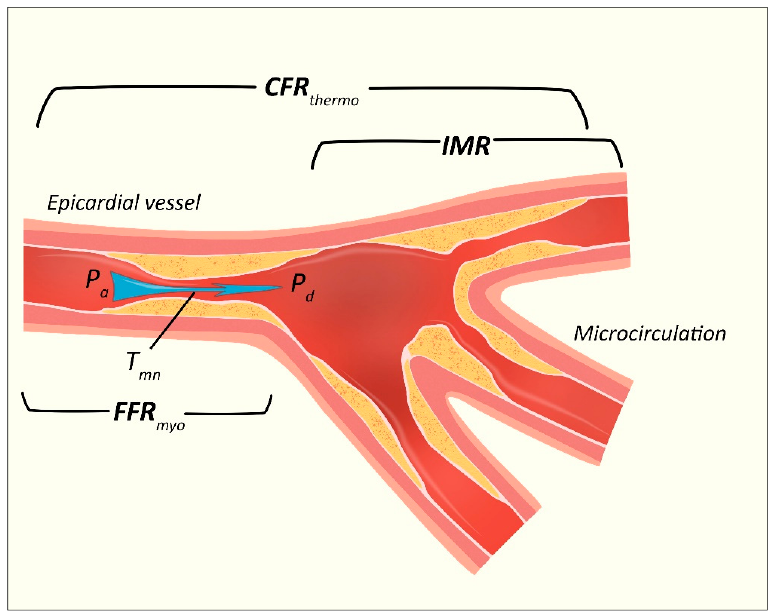
Figure 2. Invasive Assessment of the Coronary Microvasculature. CFR thermo = coronary flow reserve derived from thermodilution; IMR = index of microcirculatory resistance; Pa = mean proximal coronary pressure; Pd = mean distal coronary pressure; T mn = mean transit time; FFR myo = fractional flow reserve (specific to myocardial blood flow).